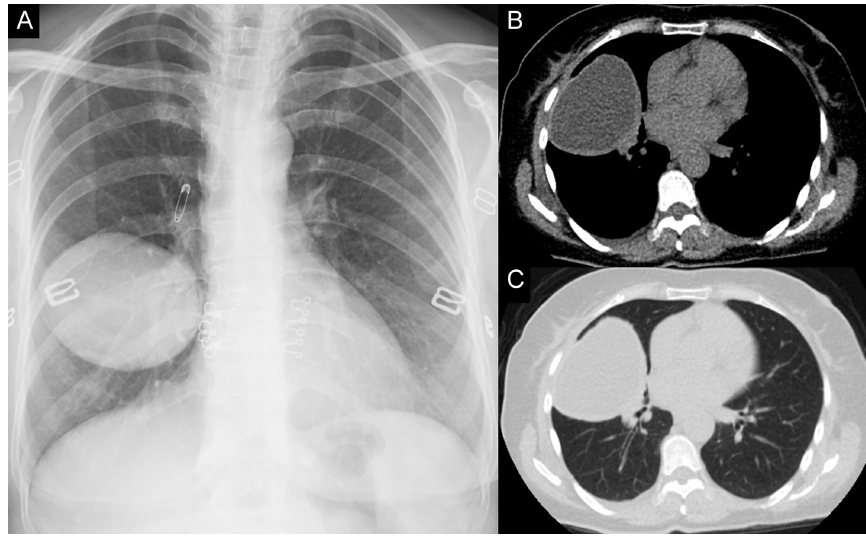
Figure 1. a-c. In a 60-year-old female, an intact hydatid cyst of approximately 9 cm in diameter originating from the lower lobe of the right lung is seen in posteroanterior chest x-ray (a), thorax computed tomography sections of the mediastinum (b) and parenchyma windows (c).